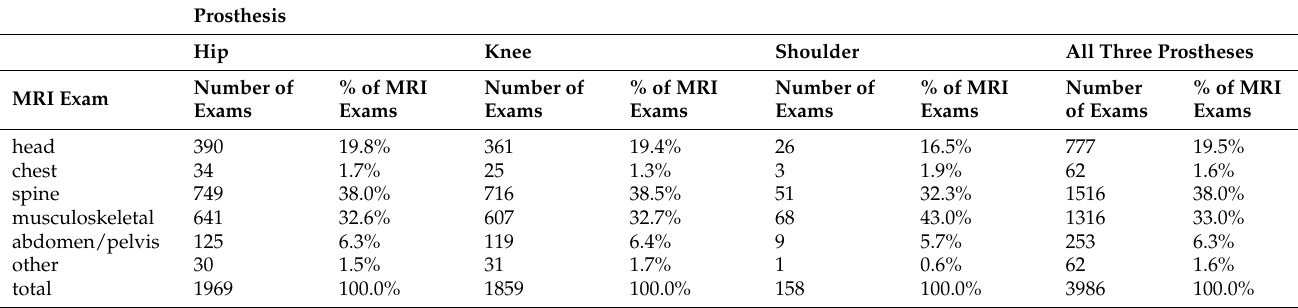
Table 2. Types of MRI exams performed within three years following the surgery for the patients with hip, knee, or shoulder prostheses implanted in